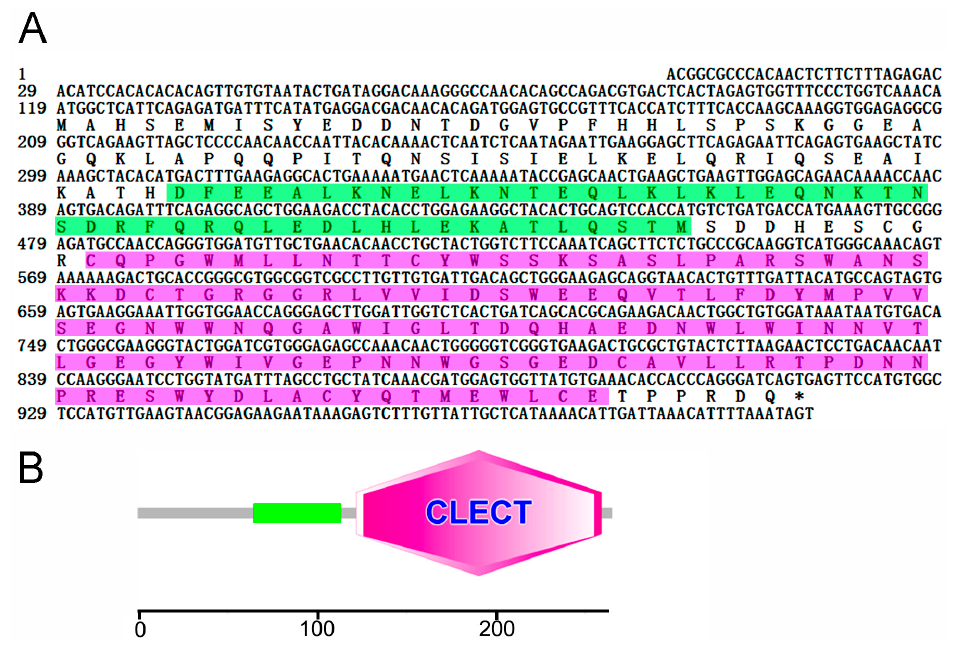
Figure 1. Sequence analysis of CsCD209. ( A ) The nucleotides and amino acids are numbered along the left margin. The translation stop codon is labeled with asterisk. The amino acid sequence of coiled-coil region and the lectin domain analyzed by SMART (http://smart.embl.de/) was boxed with green and pink respectively; ( B ) The schematic of protein motifs of CsCD209. The coiled-coil region (65–122) is indicated with green rectangle, and the lectin domain (122–259) is indicated with pink hexagon.